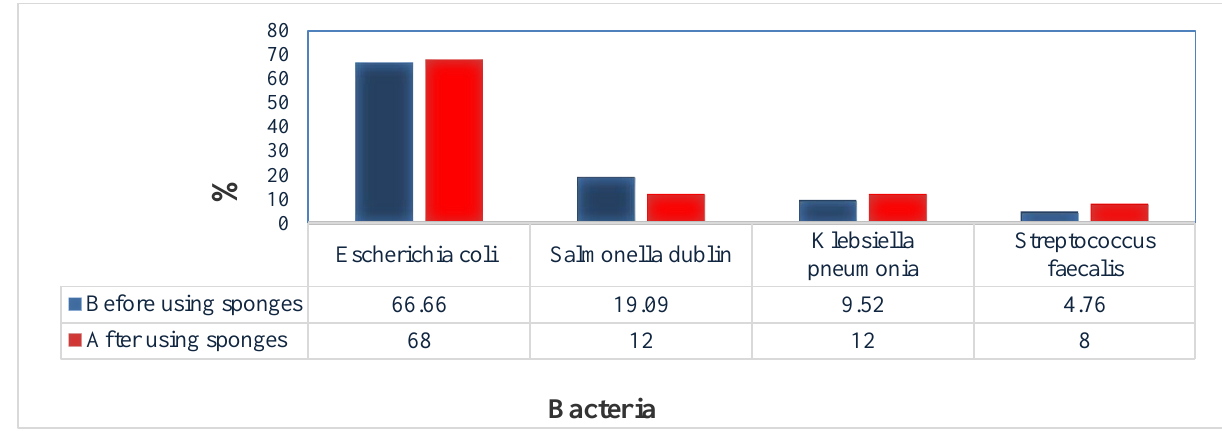
Figure, 1: Distribution of bacteria before insertion and after removal of